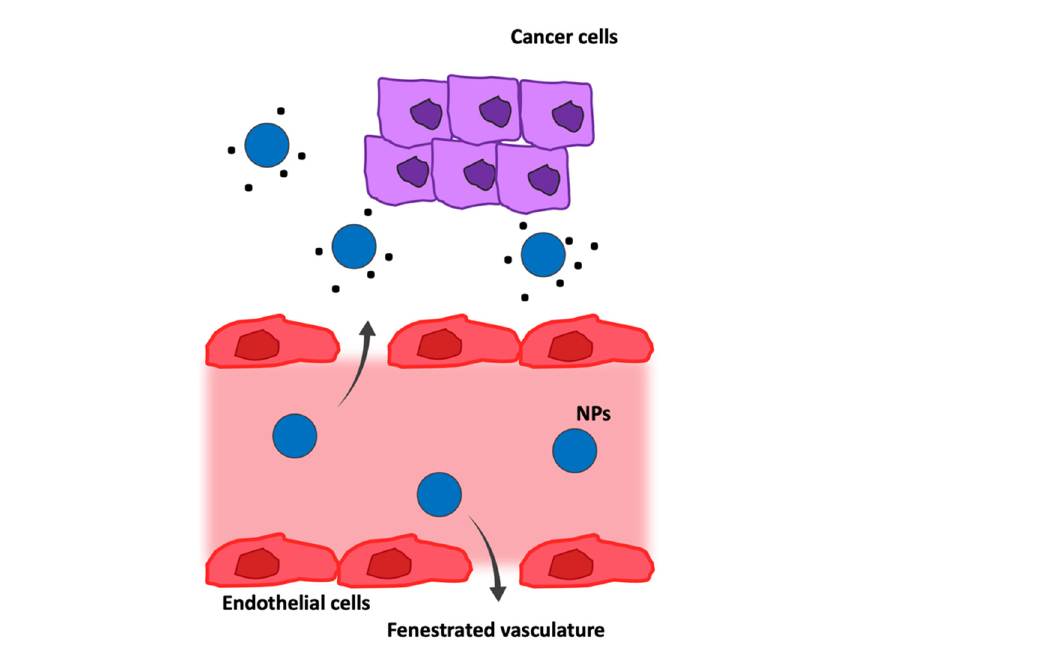
Figure 6. Passive targeting. In passive targeting via bloodstream (pink), nanoparticles (blue) are designed for transport through leaky vessels (red) and the unique intra-organ pressures of tumors (purple).